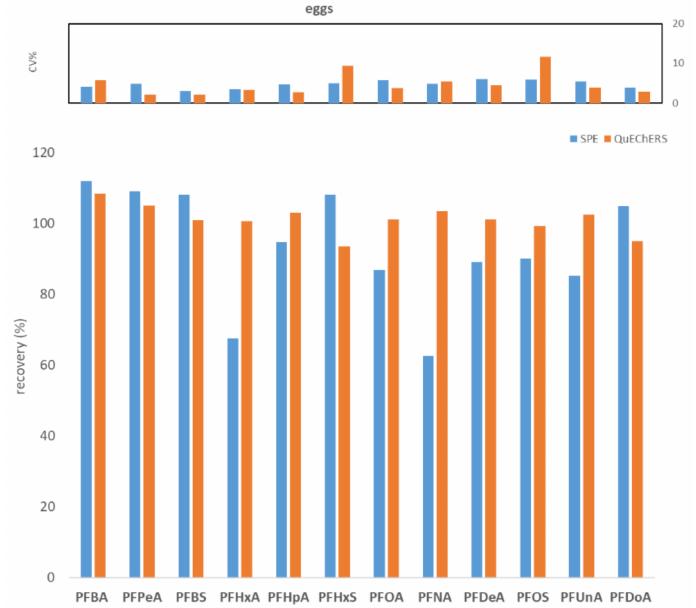
Figure 3. Comparison between SPE and QuEChERS in terms of repeatability (calculated as CV% of seven replicates at 100 ng/kg) and recovery (calculated as the average of seven replicates at 100 ng/kg) for the hen eggs matrix.